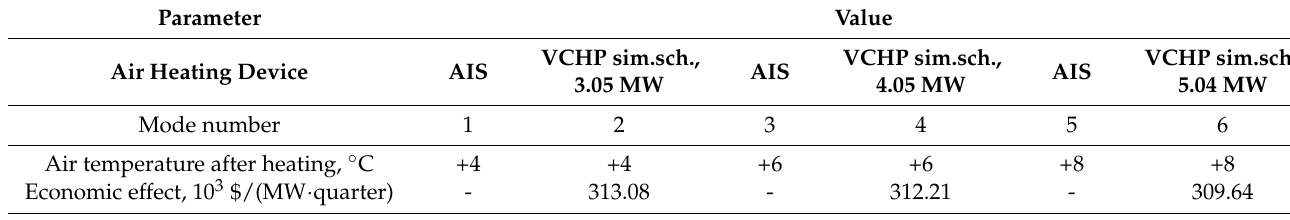
Table 12. Winter mode simulation results of using VCHPs for heating the intake